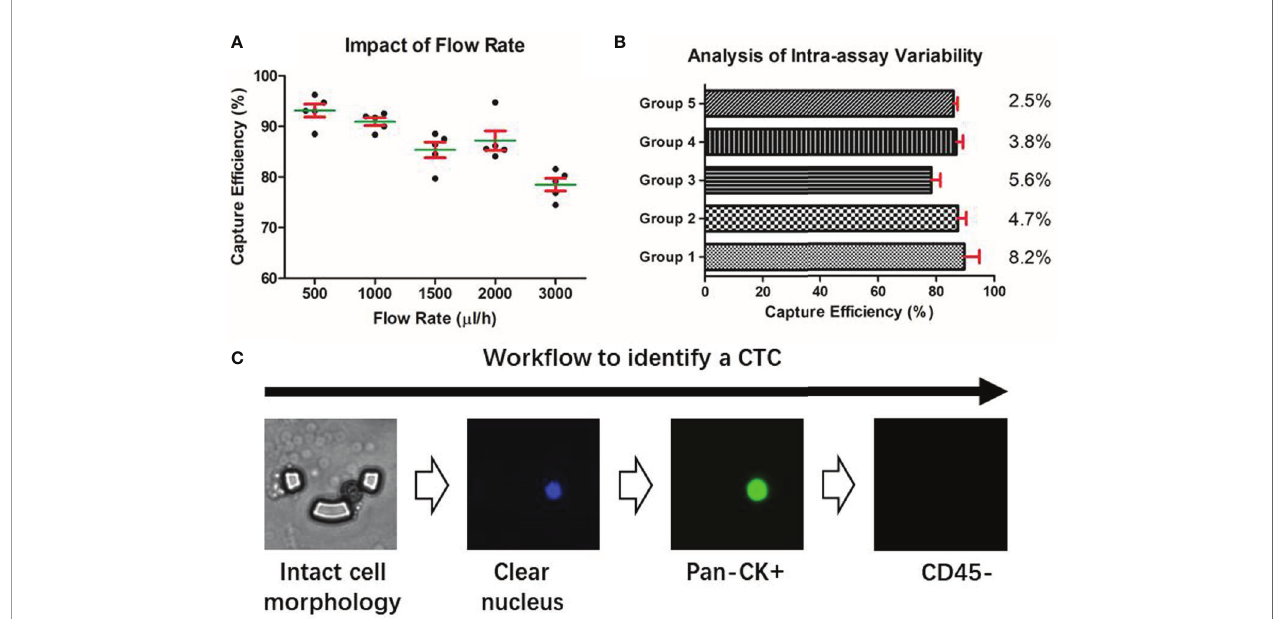
FIGURE 2 | Characterization of the micro fl uidic approach. (A) Capture ef fi ciency of the micro fl uidic chip. (B) Intra-assay variability of the micro fl uidic assay under different cell concentration groups. (C) Identi fi cation of a putative CTC based on the micro fl uidic